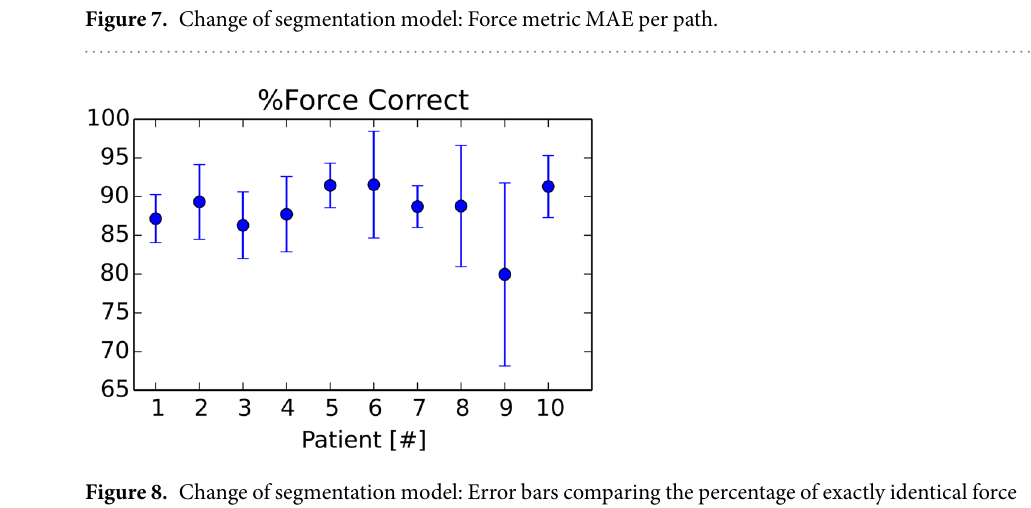
Figure 8. Change of segmentation model: Error bars comparing the percentage of exactly identical force outputs per path for each